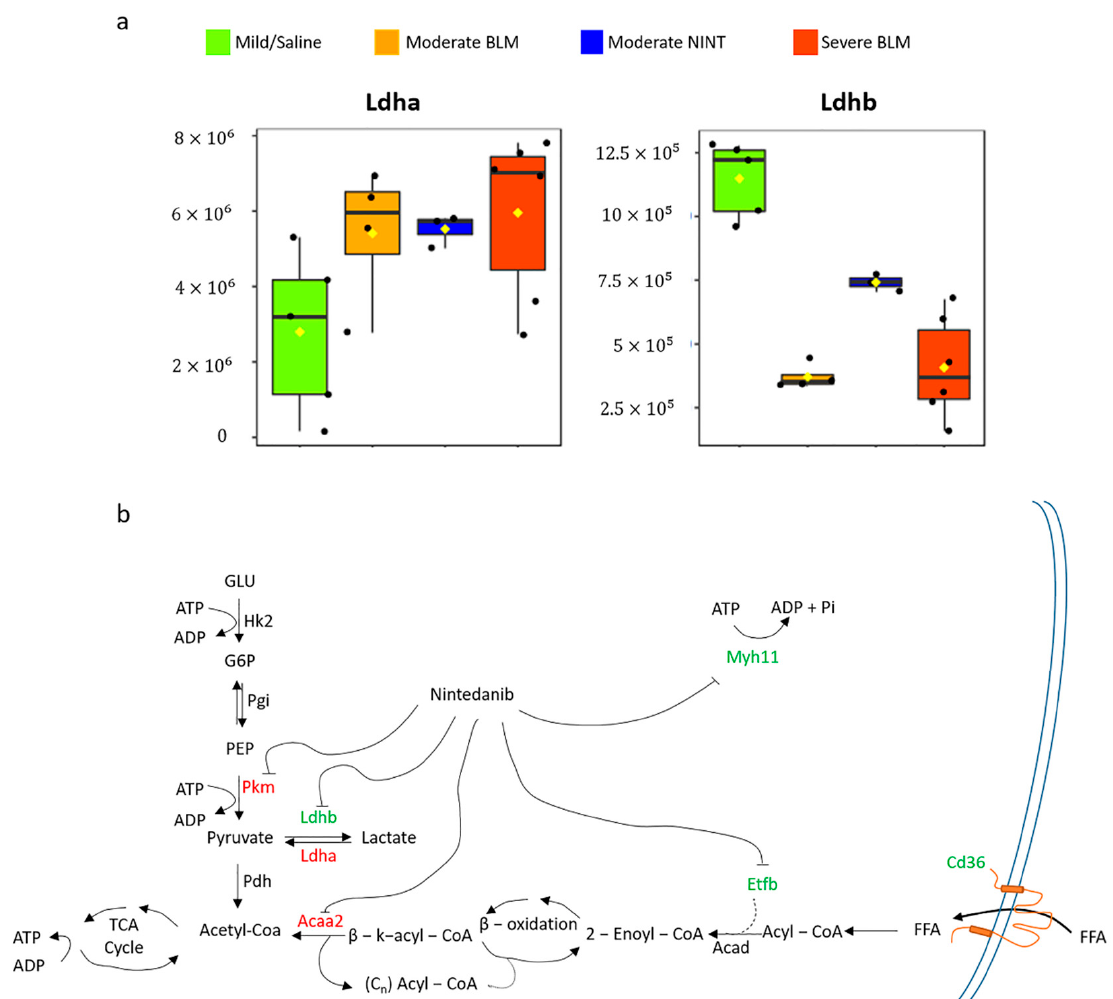
Figure 6. ( a ) Boxplots of lactate dehydrogenase A (Ldha) and lactate dehydrogenase B (Ldhb) in mild (green), moderate BLM (orange), moderate NINT (blue), and severe BLM (dark orange). Black dots represent the abundance of the selected features in all samples, yellow diamond represents the mean abundance. ( b ) Map of the pathways altered in moderate fibrosis and proteins modulated by nintedanib action ( p -value adj ≤ 0.05, FC ≥ 1.5 or ≤− 1.5). The proteins upregulated and those downregulated in moderate fibrosis compared to mild are colored in red and green, respectively.